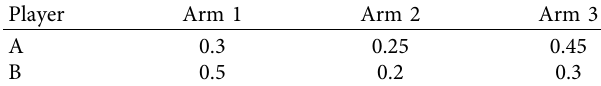
Table 3: Example of a preference